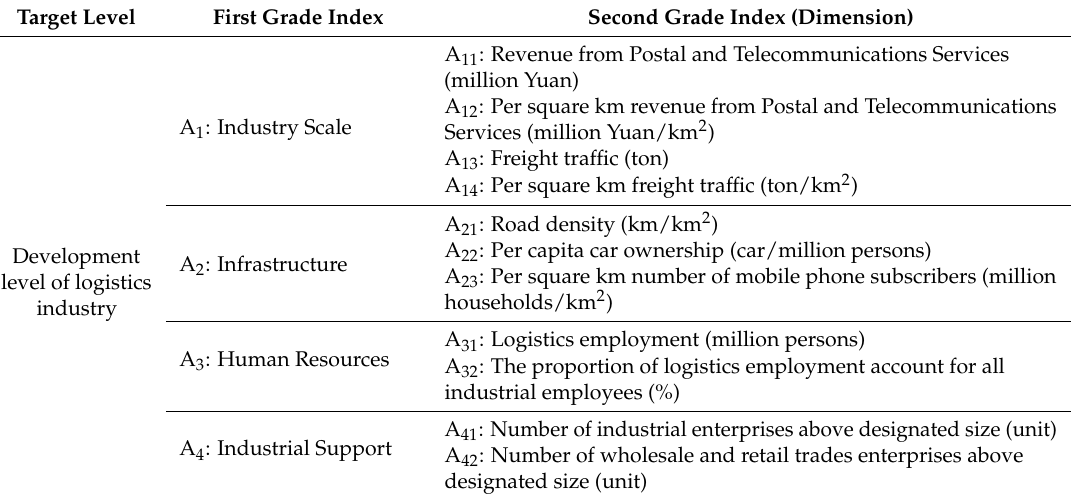
Table 1. Evaluation Index System of logistics industry development level in Yangtze River